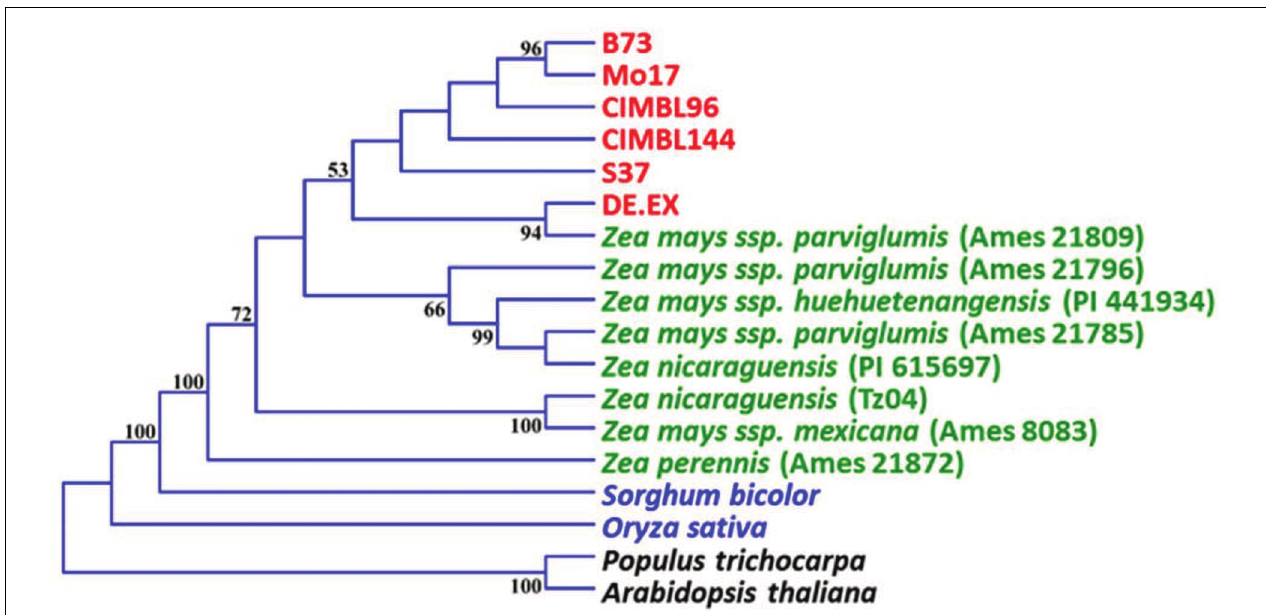
FIGURE 2 | Phylogenetic analysis of ZmARF31 in six maize inbred lines, eight teosinte lines and representative monocot and dicot plants. Numbers on the branches are percentages based on 1,000 bootstrap repetitions, bootstrap values > 50% are